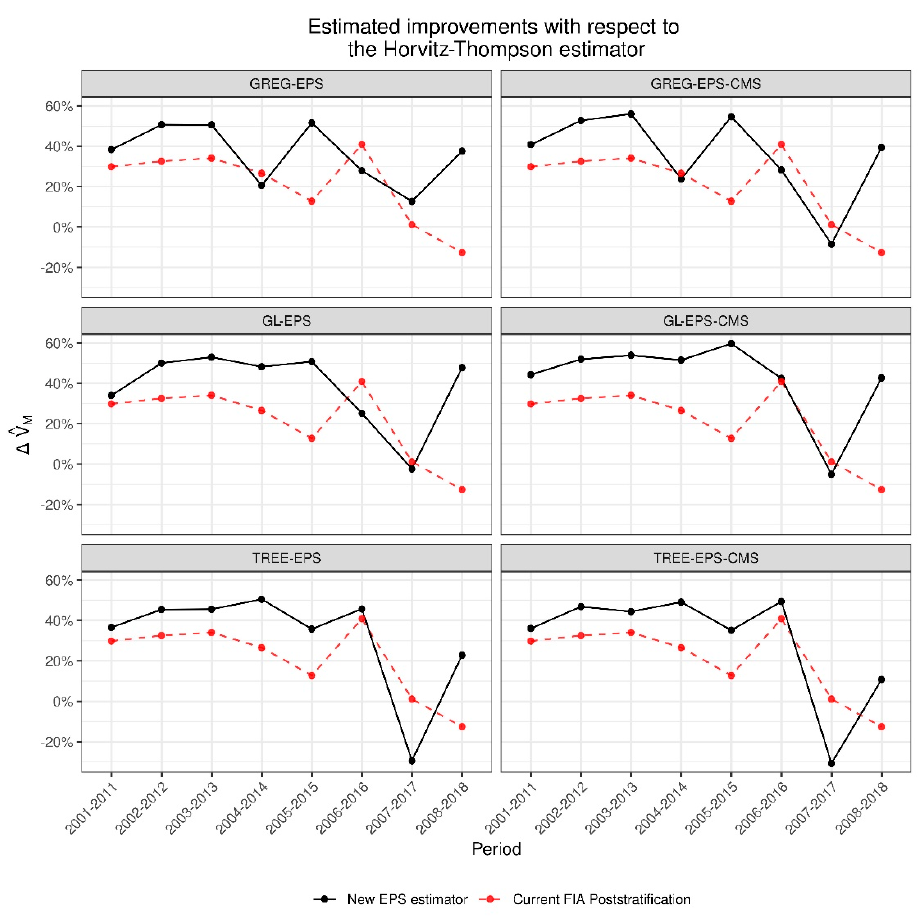
Figure 5. Estimated increases in performance, ∆ (cid:98) V M , with respect to the Horvitz Thompson, HT, of FIA-PS and EPS estimators. ∆ (cid:98) V M is 1 minus the ratio of the variance of the FIA-PS or EPS estimator to the variance of the HT estimator.